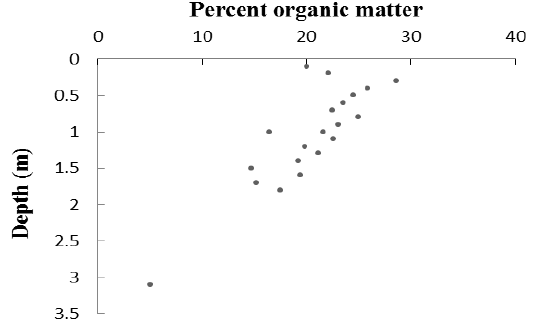
Figure 8. Percentage organic results from the Moukouke Island core.